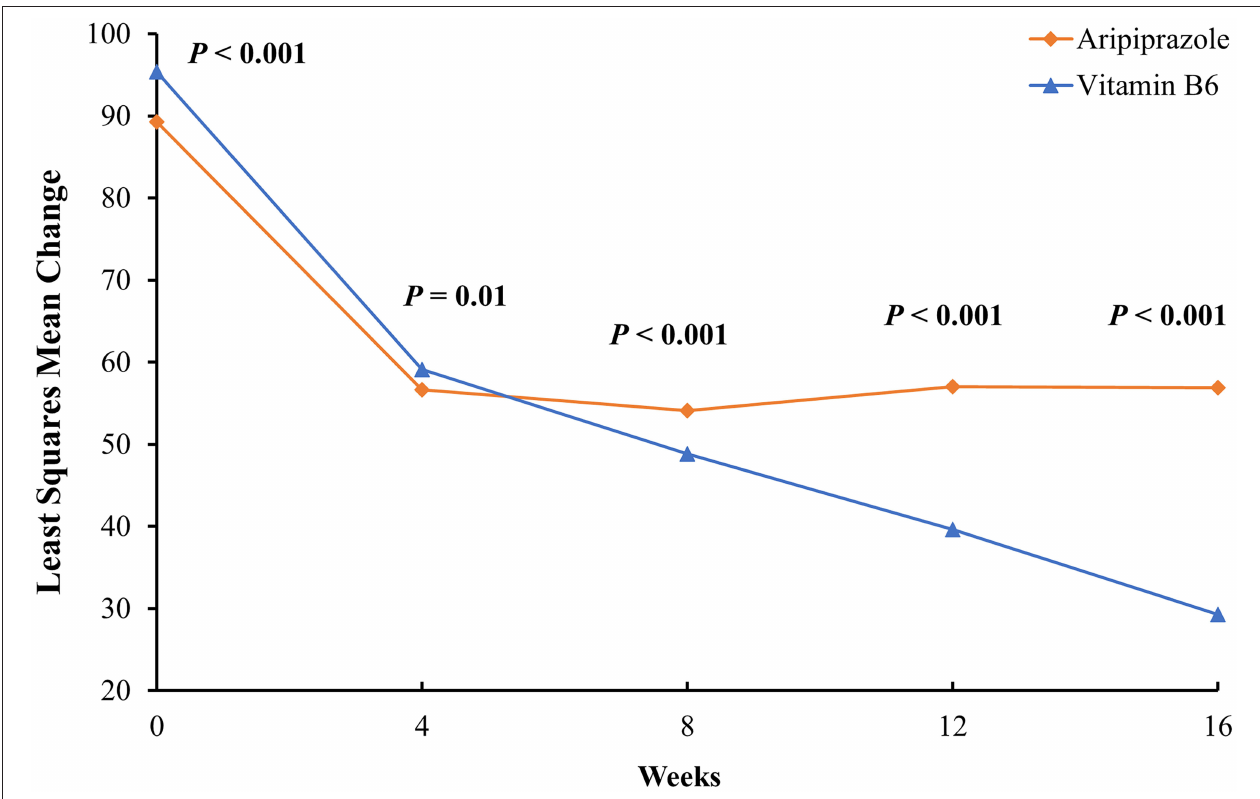
FIGURE 2 | Least-squares mean change in serum prolactin levels from baseline to week 16 in men with TRS. The data were adjusted for age, education level, total drug dosage, blood triglyceride level, and blood cholesterol level. Note that although the vB6 group had, on average, higher serum prolactin levels than the ARI group, by week 4 both had achieved similarly pronounced reductions. Moreover, after week 4, prolactin levels leveled off in the ARI group while continuing to reach lower levels in the vB6 group.